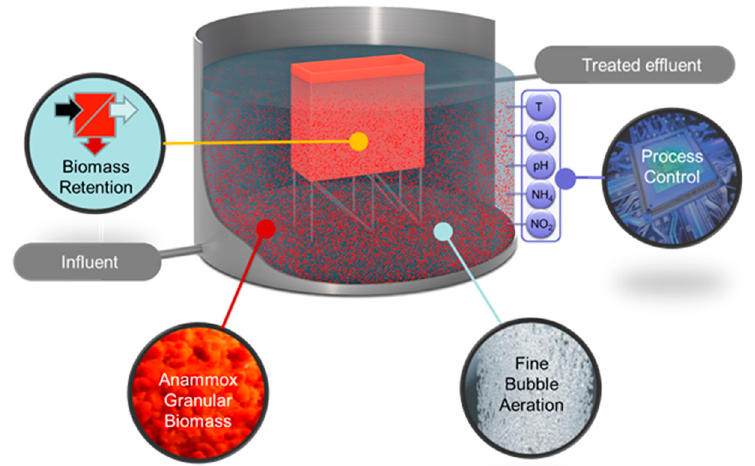
Figure 3. Typical features of the PN/A ANAMMOX reactor with an internal biomass retention system, granular biomass, fine bubble aeration system, and multiple parameter control unit.